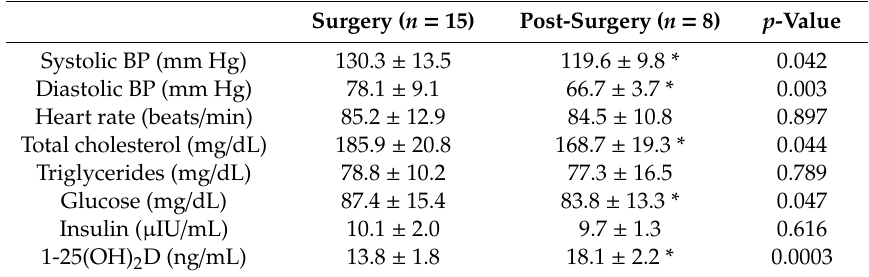
Table 2. Cardiometabolic risk factors of participants at the time of surgery ( n = 15) and three